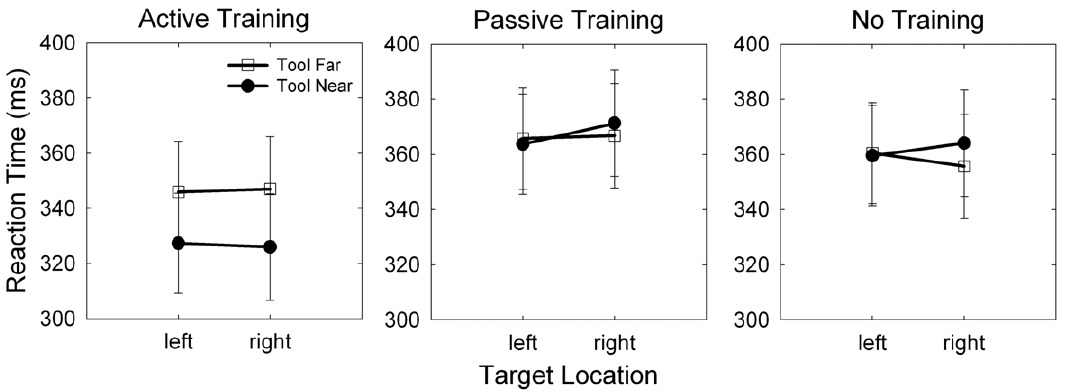
Figure 4. Reaction time (RT; ms) as a function of training condition, tool location, and target location. The active training group responded to targets more quickly when the tool was held near the display rather than far from it (training condition x tool location interaction: p=.014). This effect did not interact with target location (3-way interaction, p=.114). Error bars represent 95% confidence intervals.